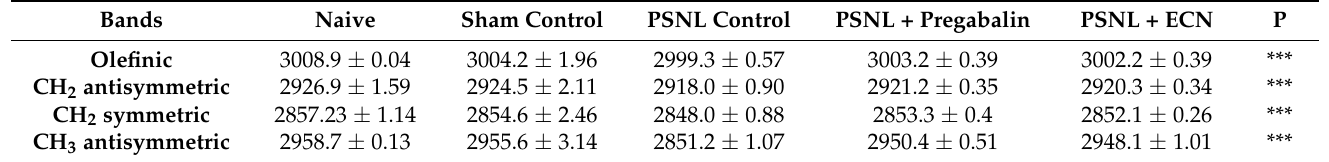
Table 2. The changes in the band wavenumber values of sciatic nerve spectra in the range of 3025–2800 cm − 1